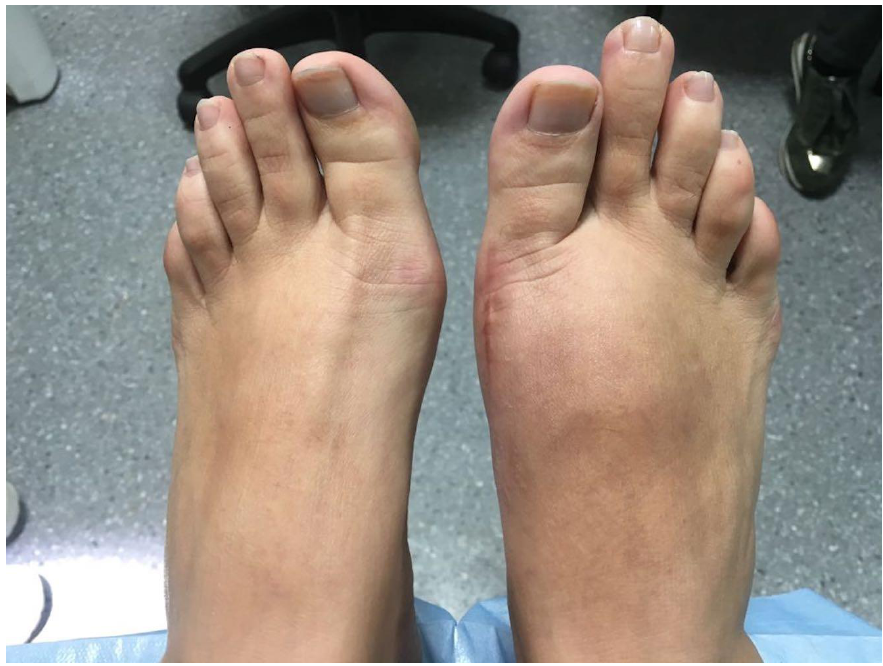
Figure 1. Image of appearance of both feet on arrival at clinic, highlighting shortening of first ra- dius of the right foot with respect to the left